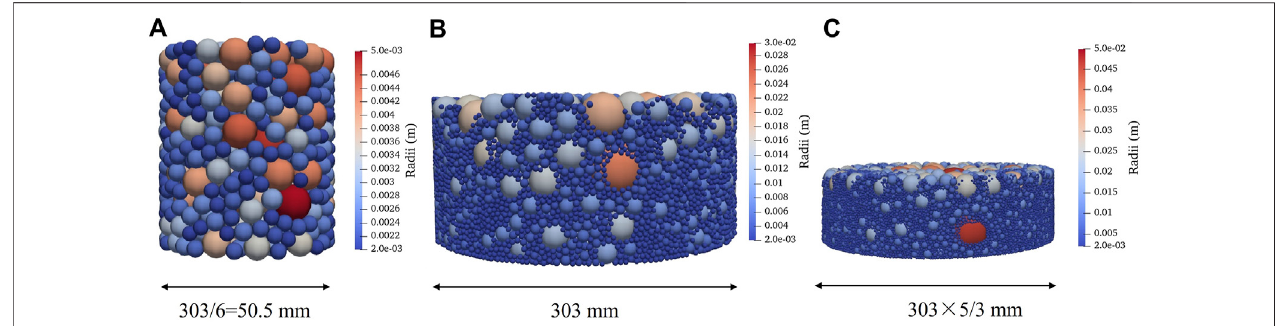
Frontiers in Physics |